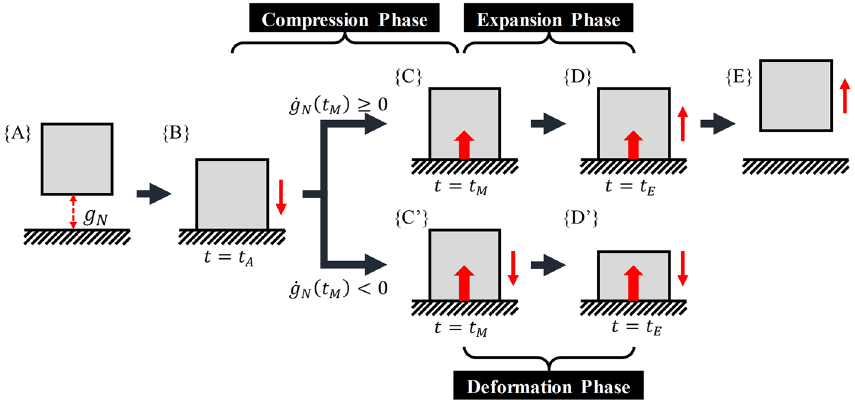
Fig. 7 State transitions 2 for collision and plastic deforma-